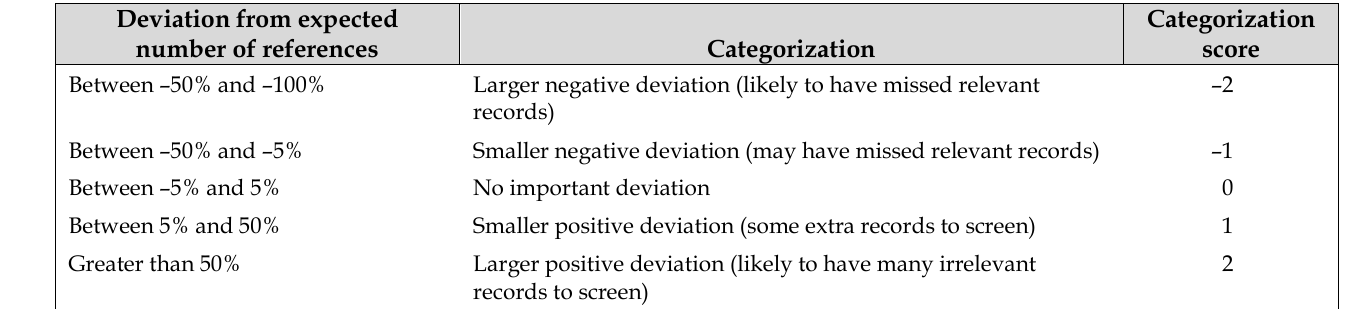
Table 1 Categorization and scores for the difference from the expected number of references Deviation from